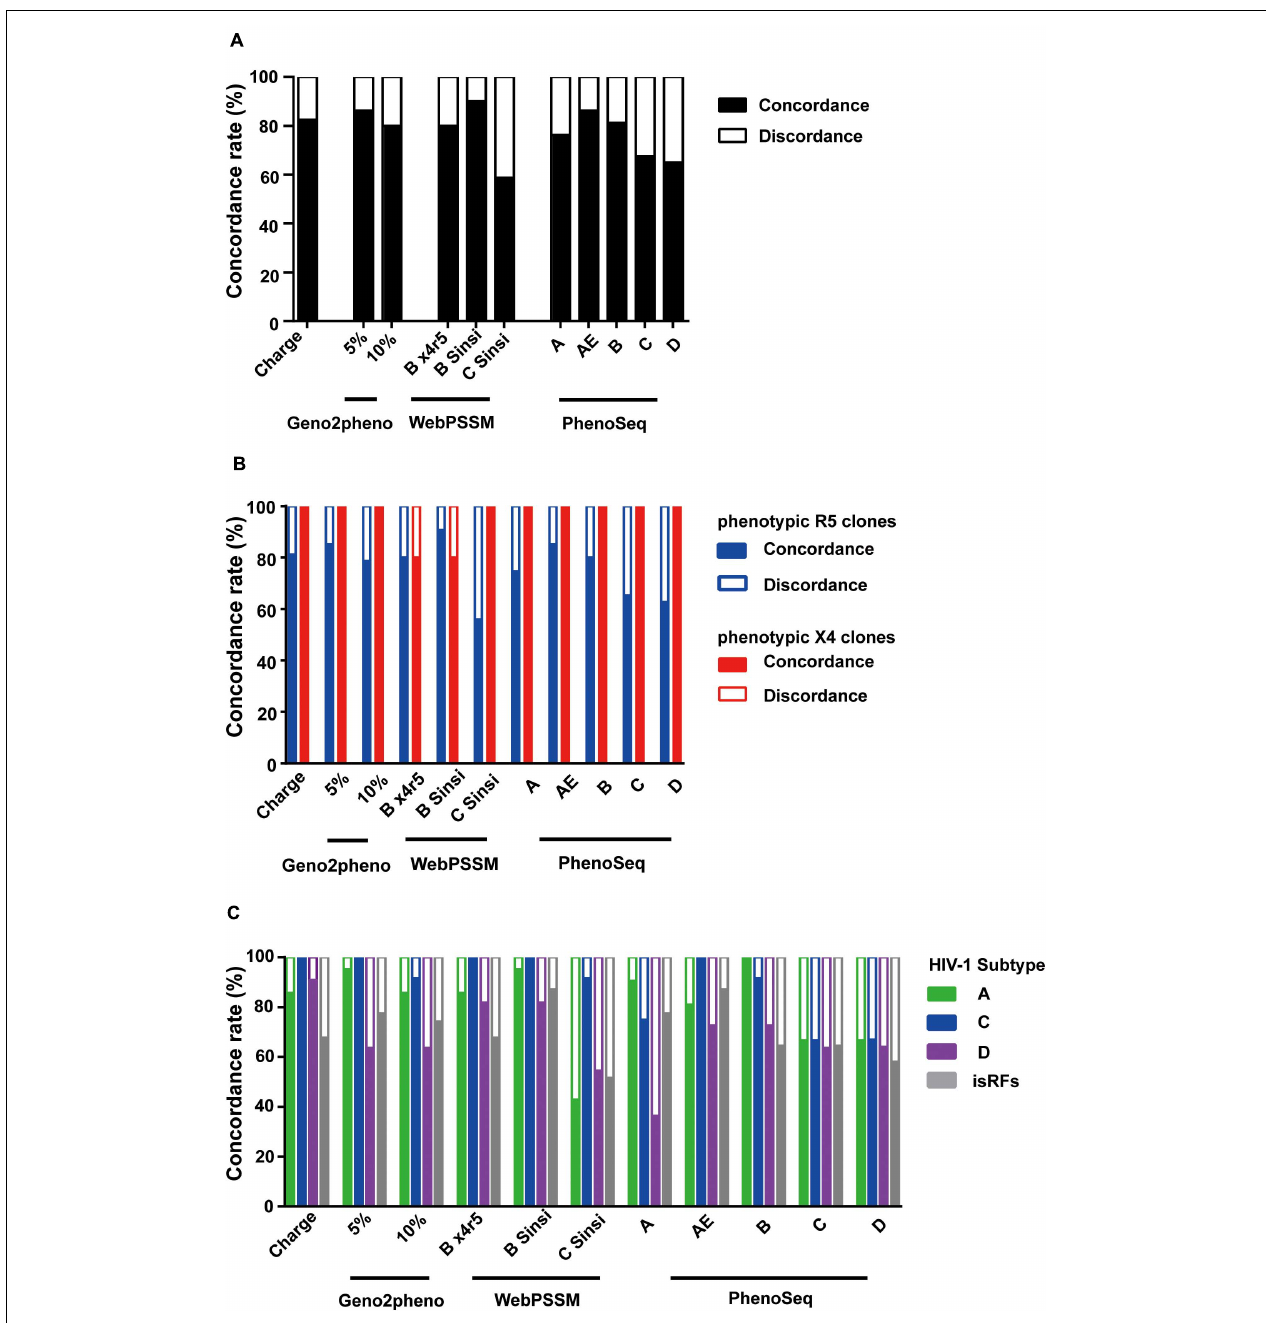
FIGURE 3 | Comparison of phenotypic and genotypic tropism testing. Testing genotypic algorithms of the panel of envelope clones with respect to phenotypic tropism data. The genotypic result was considered concordant when it correctly matched the phenotypic result. (A–C) Concordance rate when all clones were shown (A) , when phenotypic R5 and X4 clones were separately shown (B) , and when phenotypic R5 clones were shown stratified by the pre-determined subtype information (C)